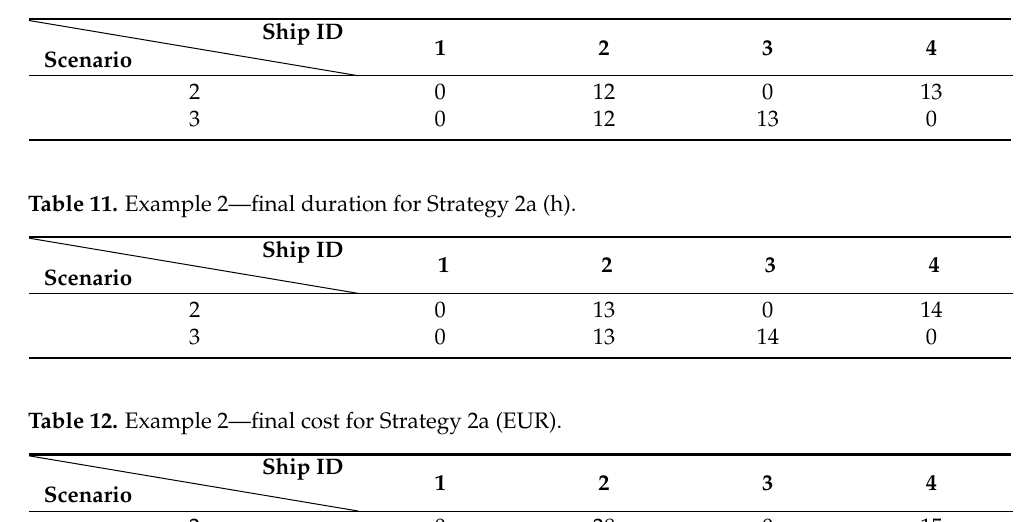
Table 10. Example 2—final allocation for Strategy 2a (m 3 ).